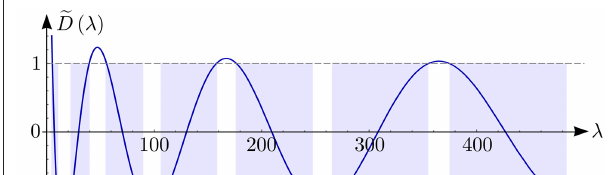
FIGURE 1 | Plot of the approximate function model from Example